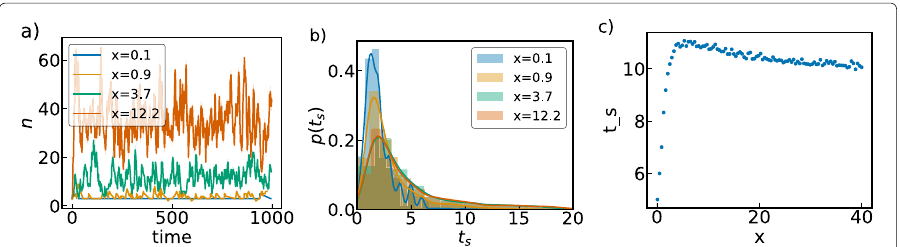
Fig. 1 Properties of the route reach an equilibrium state. a Time series of stop-list-length n for four values of x , in a 10 node ring. Higher request rate x leads to longer stop lists. b Histogram of (relative) service time t s for four values of x . A higher request rate x leads to a wider distribution of relative service times. c The mean relative service time grows with the request rate but saturates at the network size N , as for large x the bus-route covers the entire